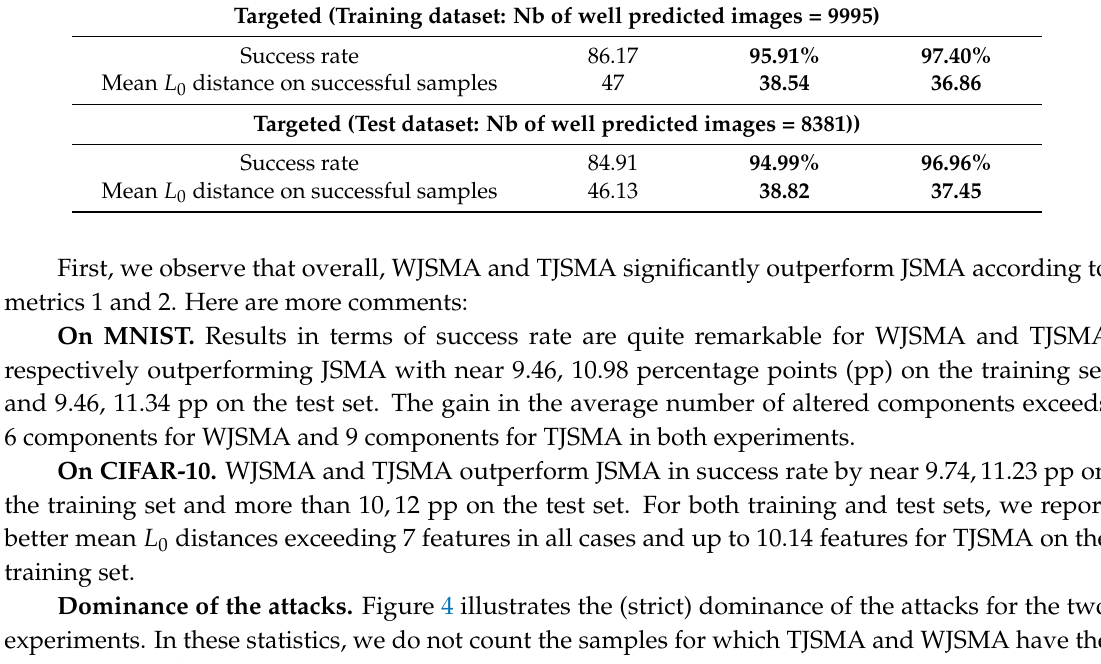
Table 2. Comparison between JSMA, WJSMA and TJSMA on CIFAR-10.